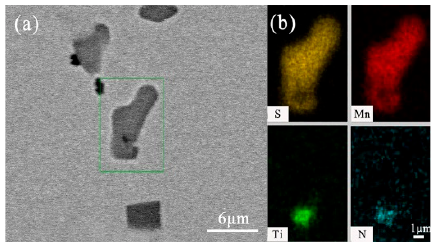
Figure 3. Typical MnS diagram with TiN as nucleation core ( a ) SEM morphology of inclusions; ( b ) composition distribution of inclusions.